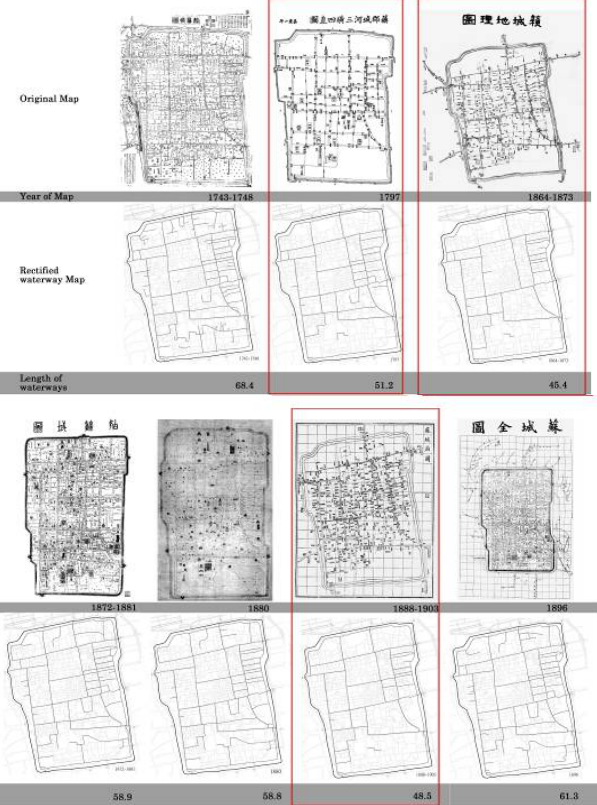
Figure 13. The maps and rectified waterways between 1743- 1903. Map code 3, 5, 6, 7, 8, 10, 11. Canals from the maps of 1797, 1864-83 and 1888-1903 are especially less compared with the data of less than 50 years adjacent. In original historical maps, a part of the canals at